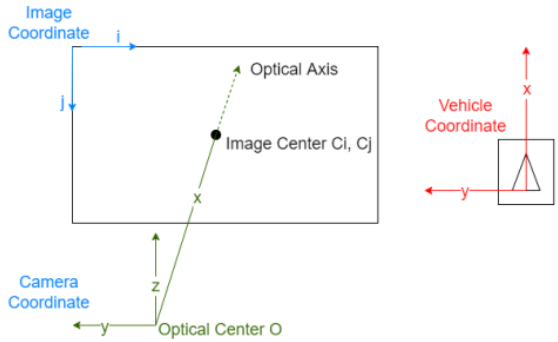
Figure 6. The coordinates in the mono camera-based tracking system.